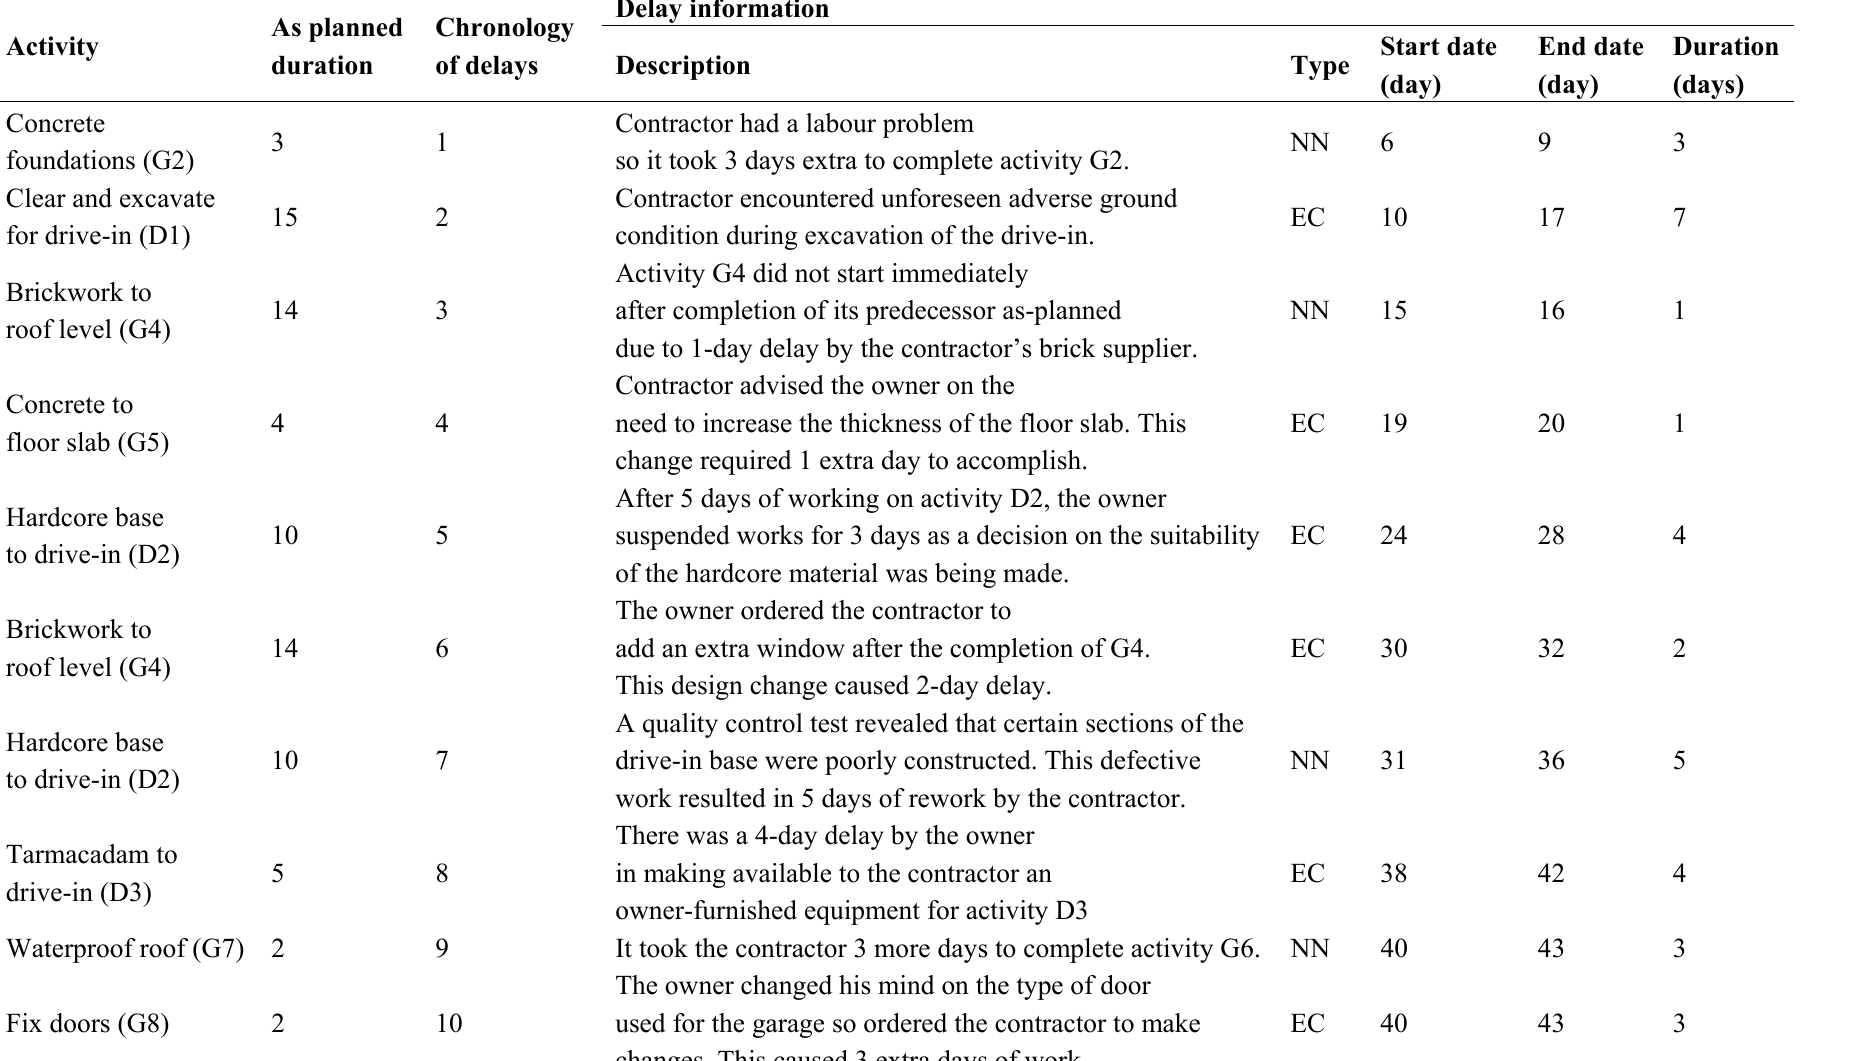
Table 1. Delays events that affected the sample